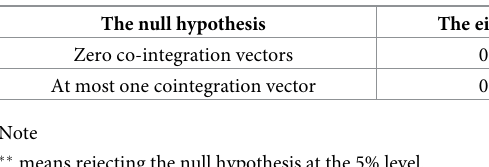
Table 3. ln y and ln x co-integration relation